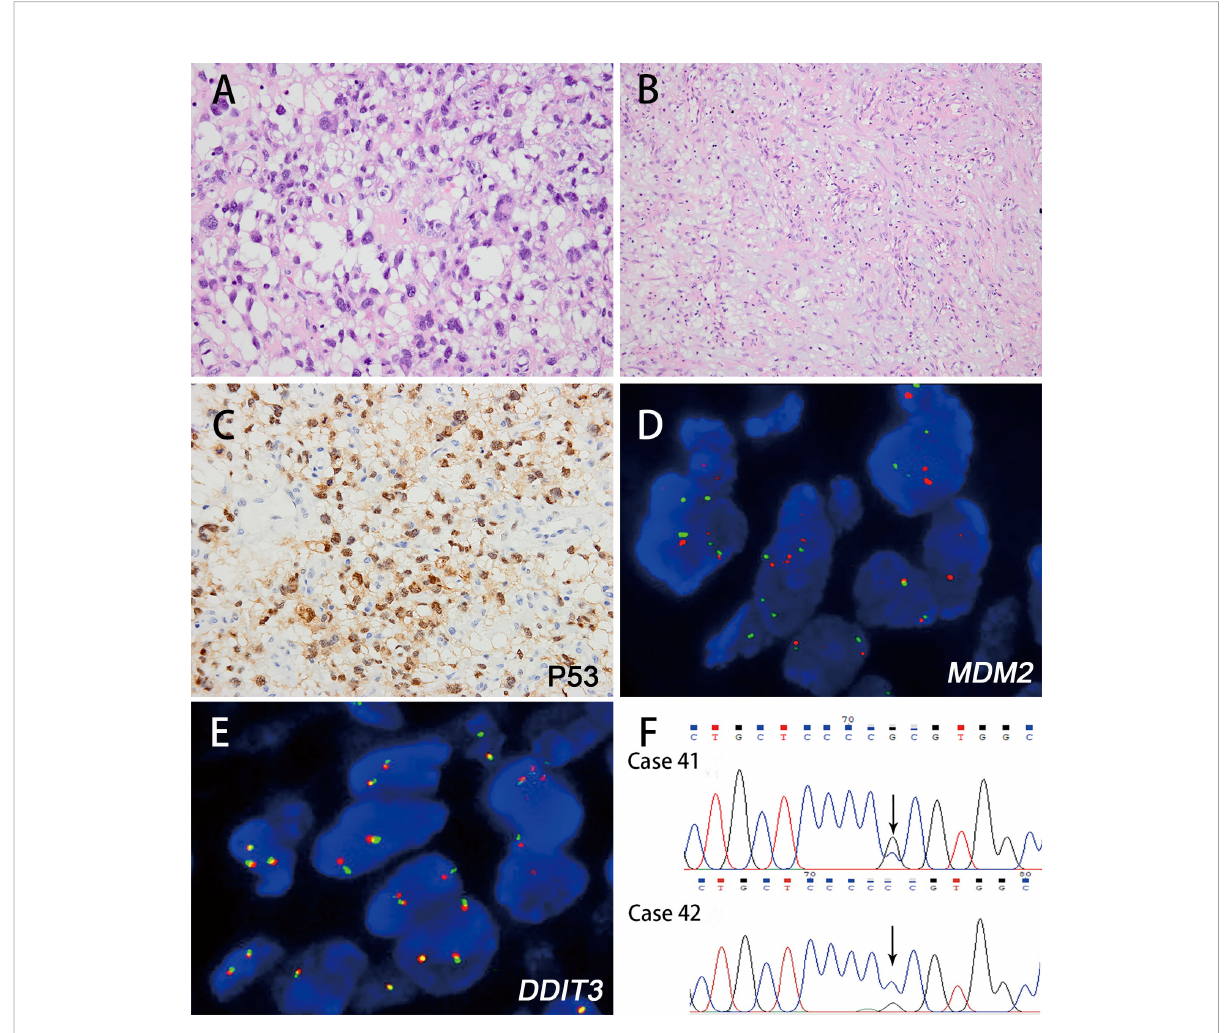
FIGURE 5 The histologic features of myxoid pleomorphic liposarcoma and corresponding immunohistochemical and genetic results. The tumor exhibited features of pleomorphic liposarcoma with myxoid matrix, and multivacuolated lipoblasts were found ( A H&E; magni fi cation: 400×) (case 42). Myxoid liposarcoma-like areas were also identi fi ed within the tumor, displaying a well-developed plexiform vasculature pattern ( B H&E; magni fi cation: 400×). The tumor cells (case 42) showed positivity for p53 immunostaining ( C magni fi cation: 400×). FISH analysis revealed negativity for MDM2 ampli fi cation (D) or DDIT3 rearrangement (E) . Sanger sequencing results showed TP53 mutations in both tumors (F)